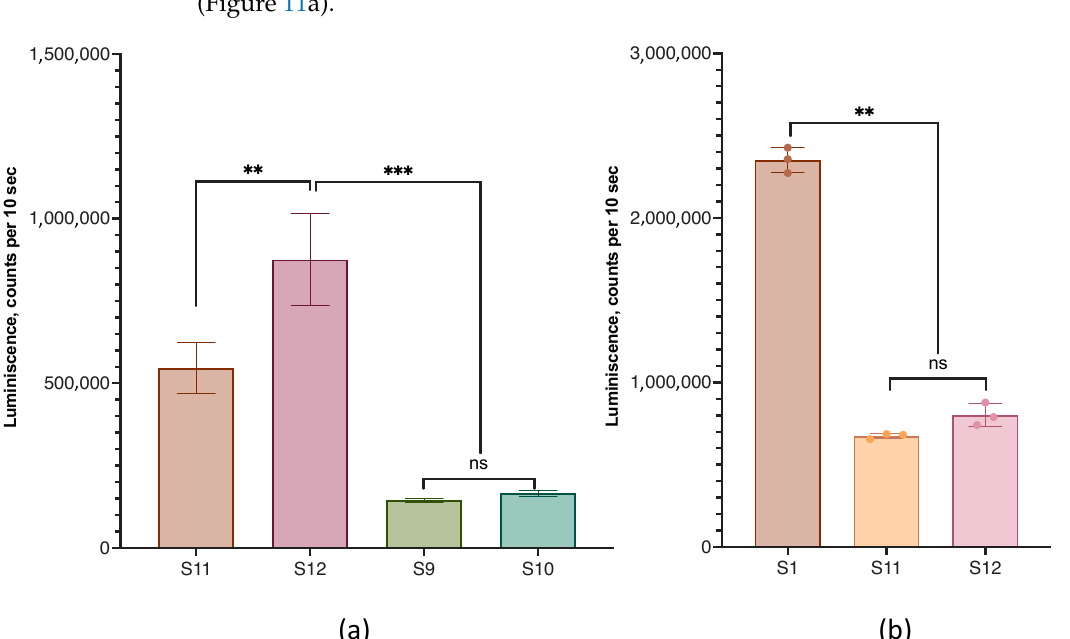
Figure 11. The efficiency of the transfection of HEK 293T cells with lipoplexes formed from LNPs with hydrophobic cores of various compositions. ( a ), Comparison of lipoplexes with different cLNP compositions. Samples S11 and S12 contained cholesterol acetate and coconut oil triglycerides in ratios of 7:7 and 4:4 mole %, respectively; samples S9 and S10 contained squalene and coconut oil triglycerides in ratios of 7:7 and 4:4 mole %, respectively (Table 1). ( b ) Comparison of the efficacy of lipoplexes prepared from LNPs (sample S1) and cLNPs (samples S11 and S12). The untreated controls did not differ from the background signal (700 counts per 10 s). Incubation time was 24 h. ns—not significant. ns. not significant, n =